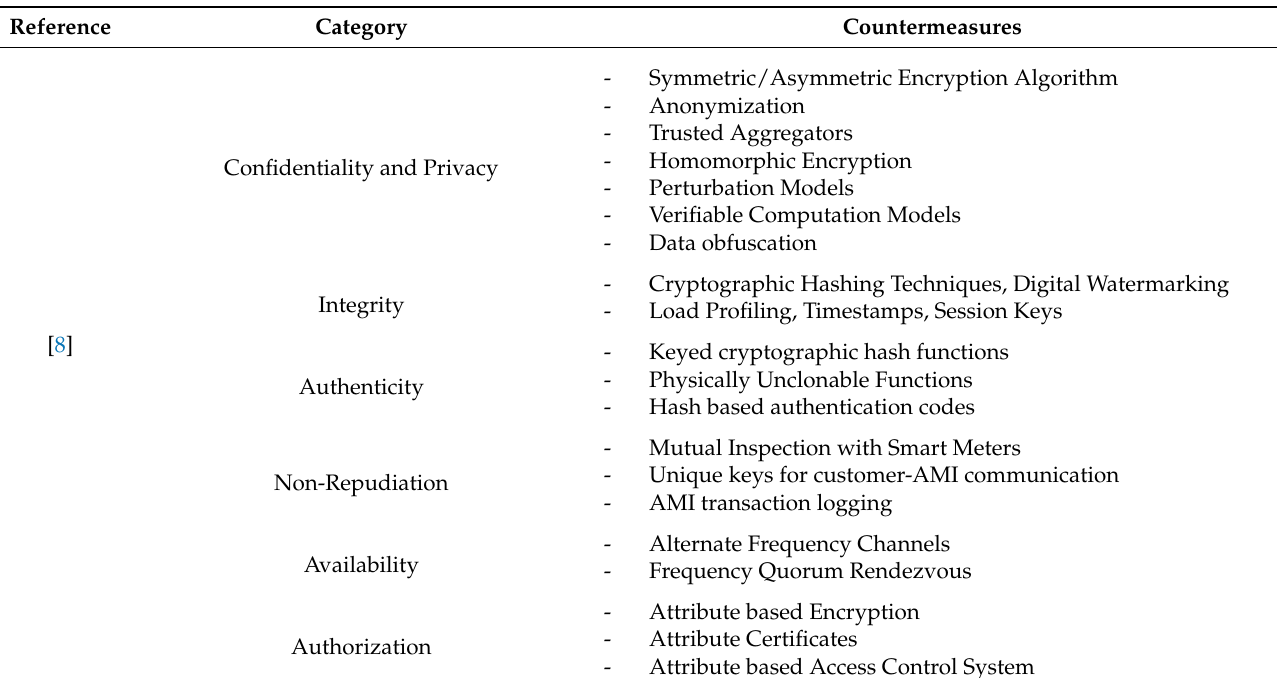
Table 3. Summary of the research papers in countermeasures for smart grid security